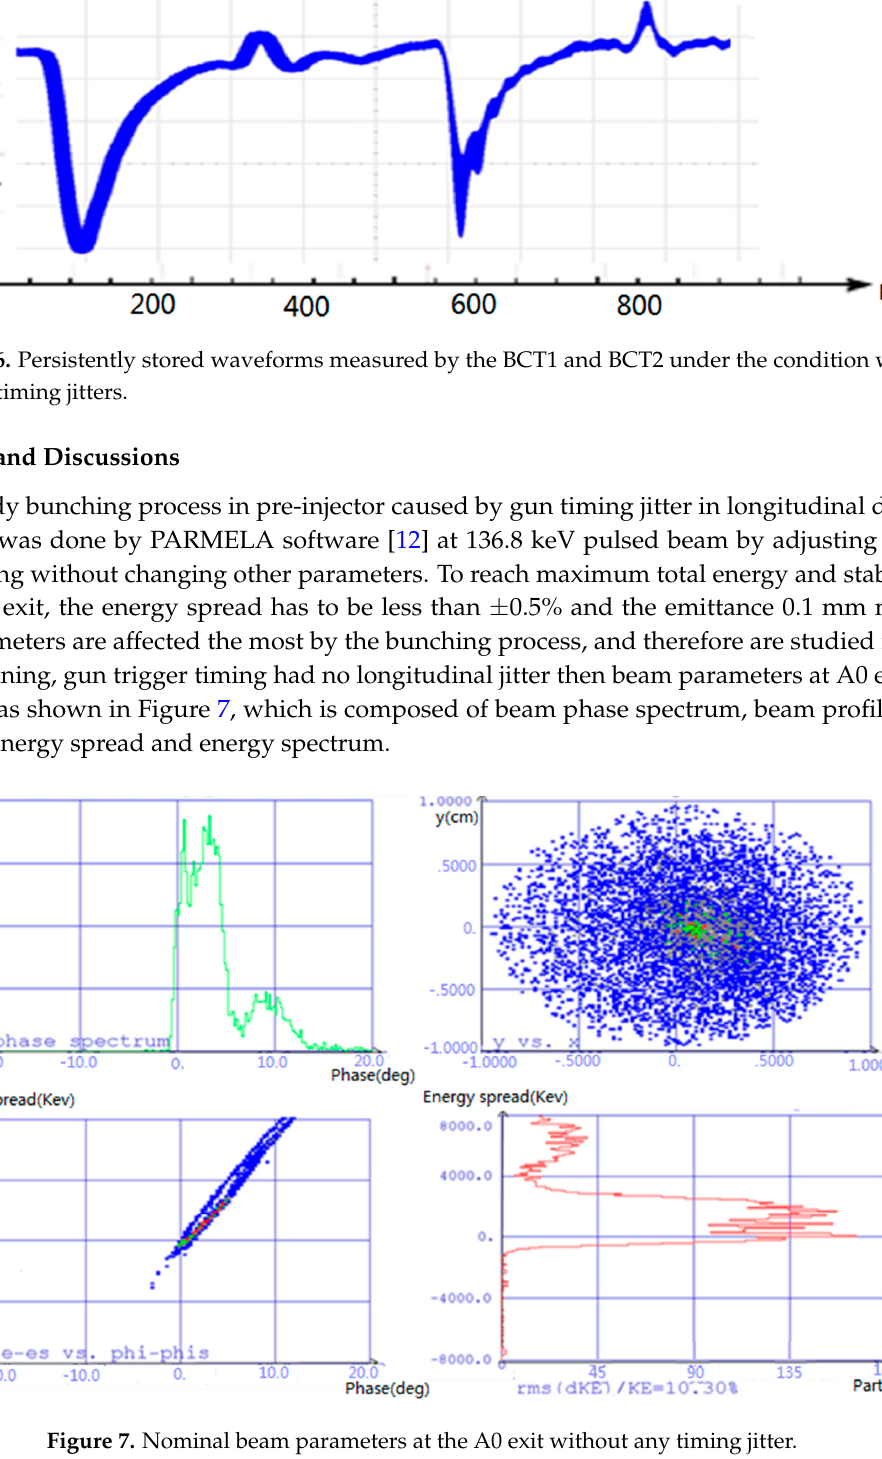
Figure 7. Nominal beam parameters at the A0 exit without any timing